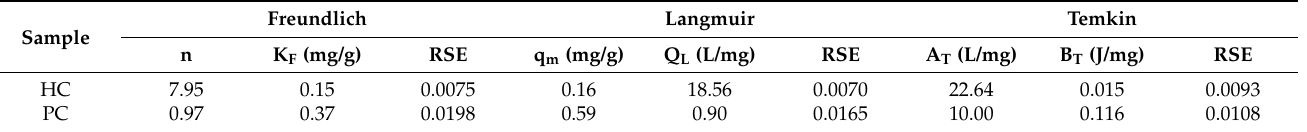
Table 5. Langmuir, Freundlich and Temkin constants for Cd adsorption isotherms on HC and PC.